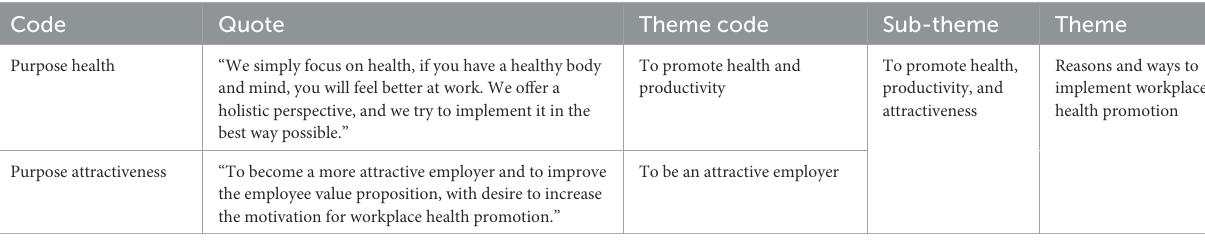
TABLE 1 Extracts of the development of themes and sub-themes.